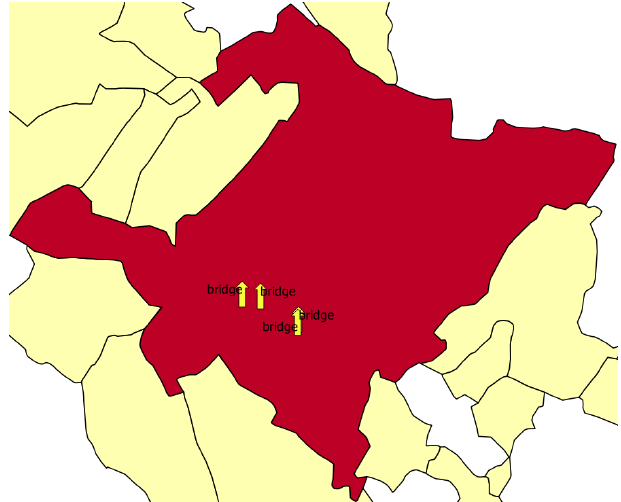
Figure 22. All dwellings in the municipality of L’Aquila damaged by the earthquake.